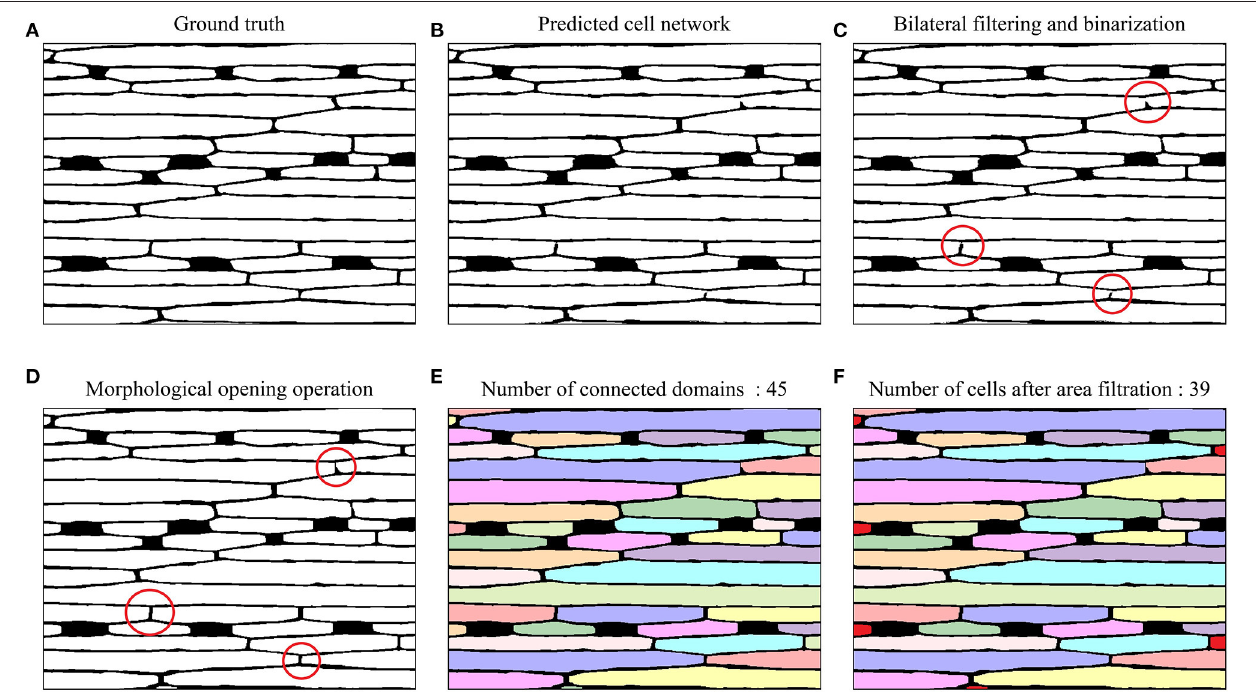
magnified microscope image of ×